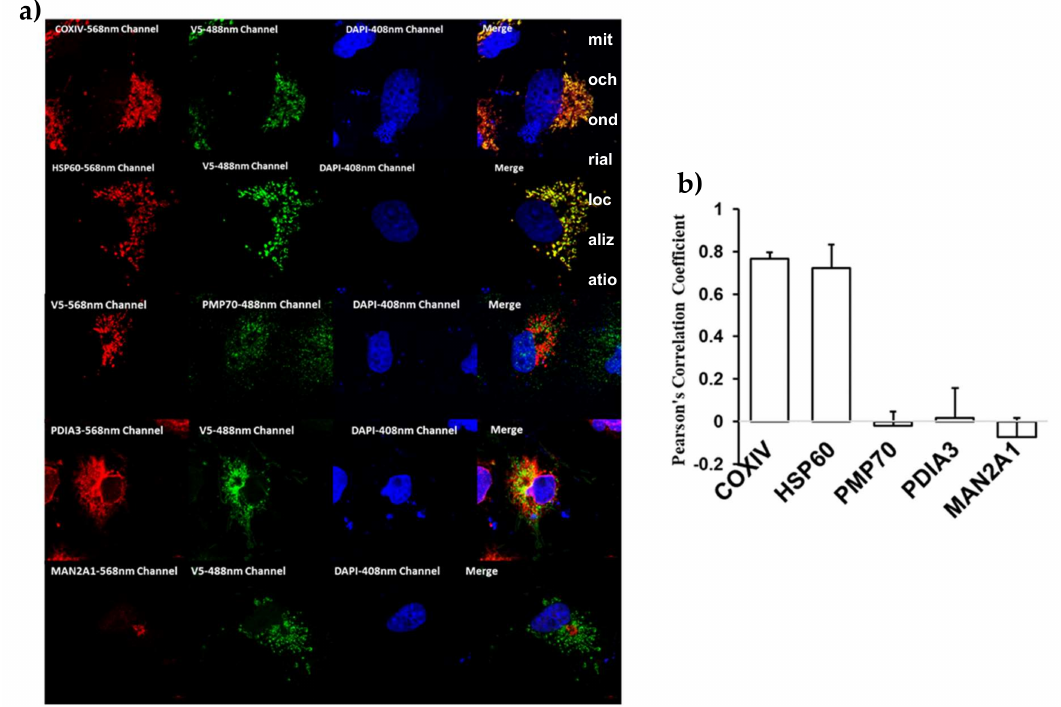
Figure 5. Characterization of BCO2 subcellular localization by immunofluorescence studies. ( a ) Subcellular localization of BCO2 / V5 / Lumio protein compared with di ff erent organelle markers. COS7 cells were transfected with BCO2 / V5 / Lumio protein, fixed 48 h following transfection, and immunostained for BCO2 using anti-V5 monoclonal mouse antibody (anti-V5-mAb) (or anti-V5 polyclonal rabbit antibody (Anti-V5-pAb) in the case of 70-kDa peroxisomal membrane protein (PMP70)), together with anti-COXIV mAb and anti-HSP60 mAb (mitochondria), anti-PMP70 mAb (peroxisomes), anti-protein disulfide-isomerase A3 (PDIA3) pAb (ER), or anti- alpha-mannosidase 2 (MAN2A1) pAb (Golgi), and analyzed by confocal microscopy. BCO2 protein shows an extensive colocalization with the mitochondrial marker proteins (COXIV or HSP60) in COS7 cells. ( b ) Pearson’s correlation coe ffi cient for colocalization of BCO2 / V5 / Lumio protein with di ff erent organellar marker proteins. Results are presented as mean ± SD for 40–50 cells for each